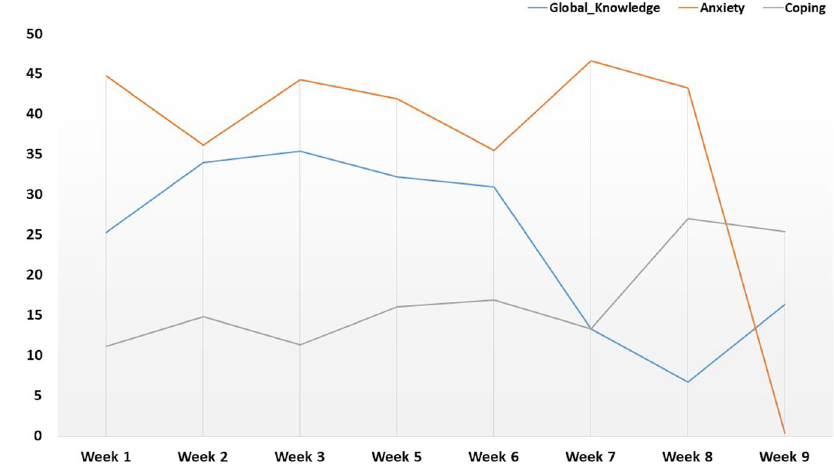
Fig. 2 The clusters ’ unique use. Evolution of the per cent of the unique use of the three relevant clusters over